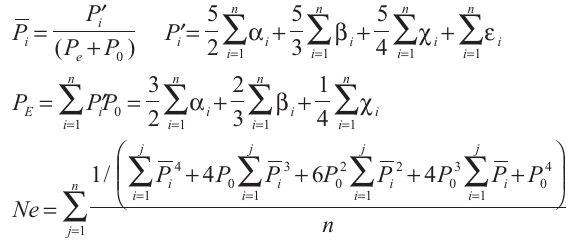
where Pi’ is the expected number of the j allele (expect for the null allele) of a locus, P is the sum of N in locus i , P is E j O the expected number of null alleles for a locus. The banding